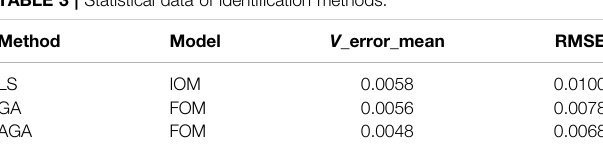
Frontiers in Energy Research |